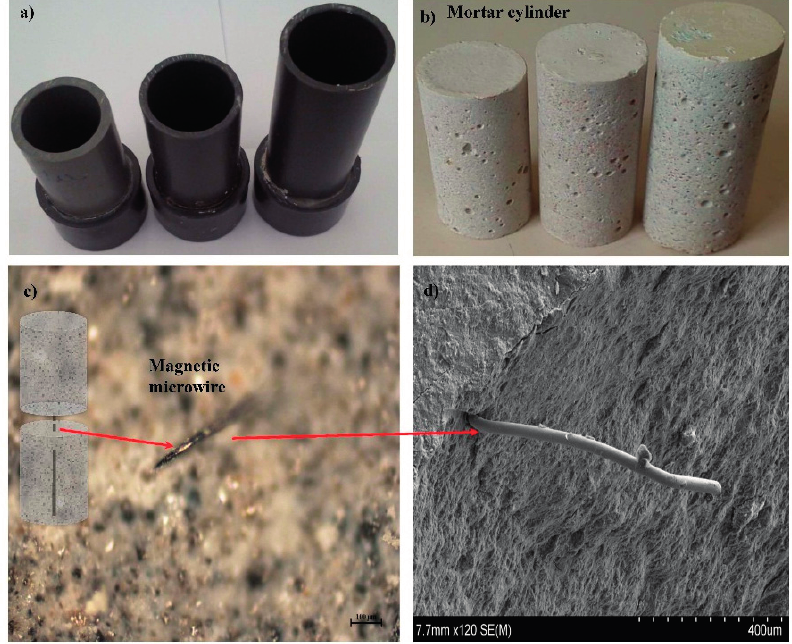
Figure 3. ( a ) Molds for MMCC sensors; ( b ) mortar cylinder with an embedded microwire; and ( c ) and ( d ) optical and electronic micrograph, respectively, of the embedded